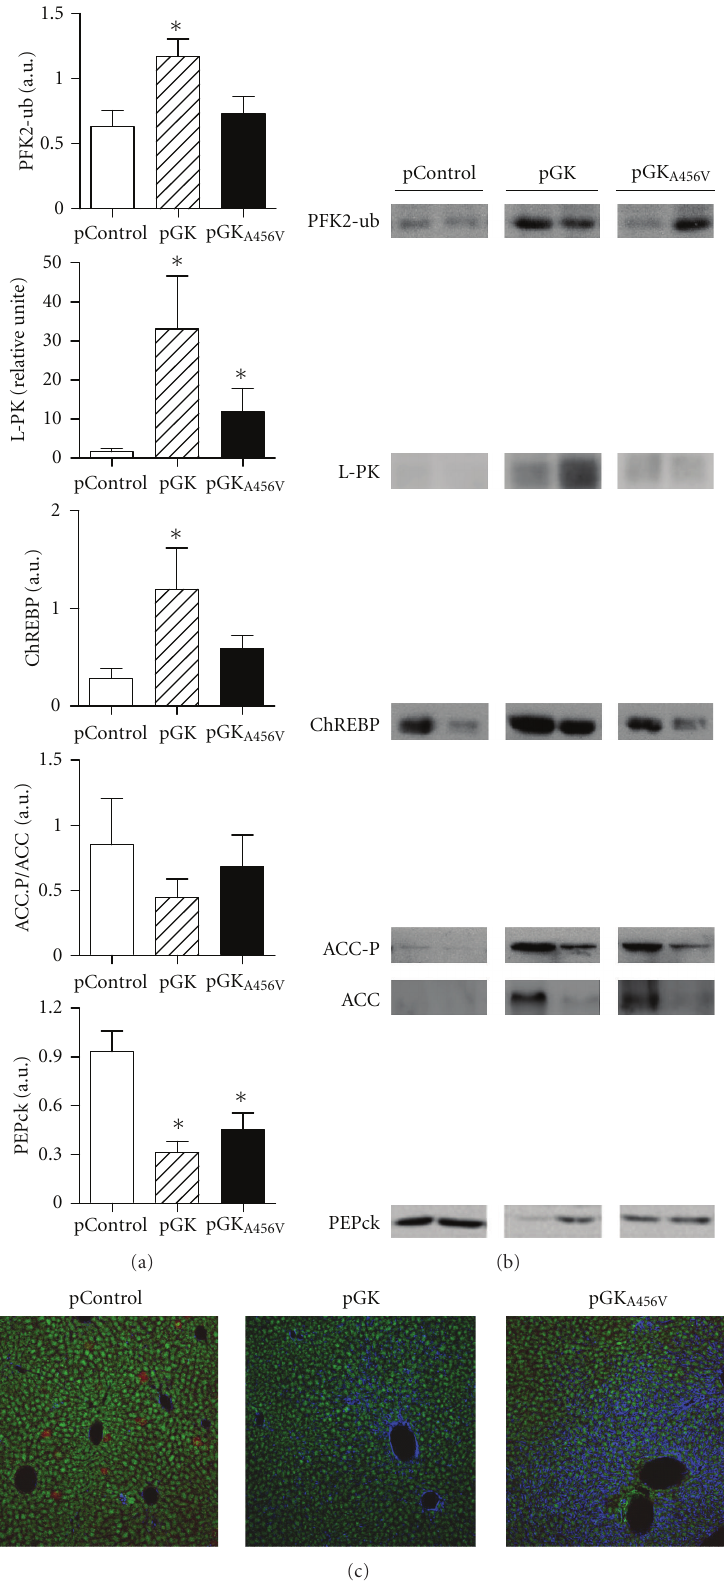
Figure 5: Analysis of protein levels in livers transfected with GK and GK A456V . Livers excised from mice in postabsorptive state were homogenized and resolved by Western blot. (a, b) Representative blots from three independent experiments. The densitometric analysis is presented ( N = 4, ∗ P < 0 . 05 versus pControl, ∗∗∗ P < 0 . 001 versus pGK A456V ). (c) Liver sections of 5-hour fasted mice injected with pControl, pGK, or pGK A456V were immunostained with Glc6Pase antibody. TO-PRO-3 was used to visualize